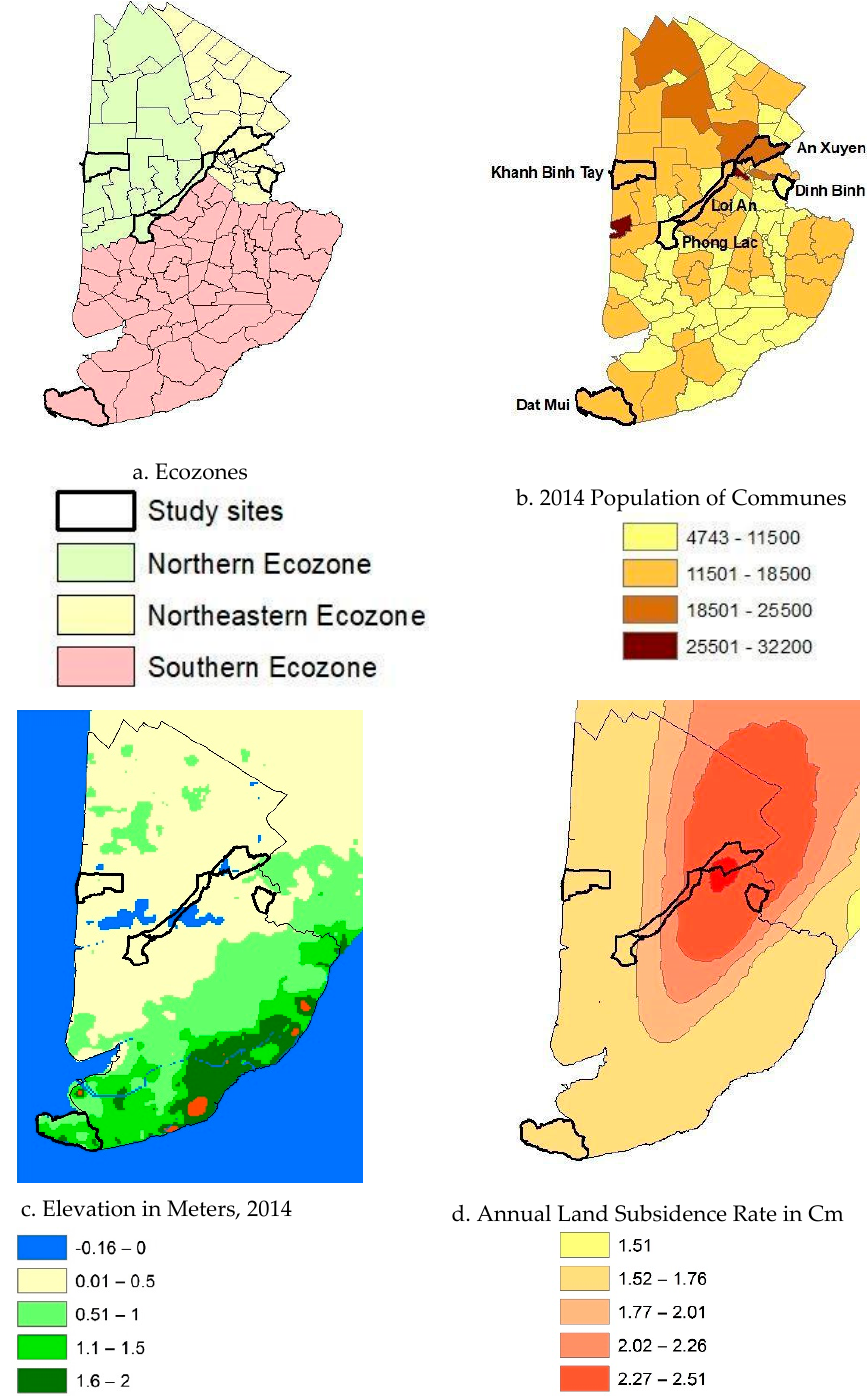
Figure 2. ( a ) Study sites within Ca Mau’s three eco-zones: (1) The northeastern eco-zone (yellow), characterized by moderate flooding and high salinity, contains An Xuyen and Dinh Binh, both in the Ca Mau City district; (2) the northern eco-zone (green) is characterized by a mixture of forests, rice and aquaculture sites and contains the study sites of Khanh Binh Tay, Loi An and Phong Lac; (3) the southern eco-zone (pink), characterized by high salinity but fewer large rivers and less flooding, contains the study site of Dat Mui 34]. ( b ) 2014 population by commune; ( c ) Elevation in meters and location of tidal gauge stations in Ca Mau province, adapted from TopoDEM [5]. ( d ) Land subsidence rates are low range estimates derived from annual averages over the 2006–2010 period [9,37].